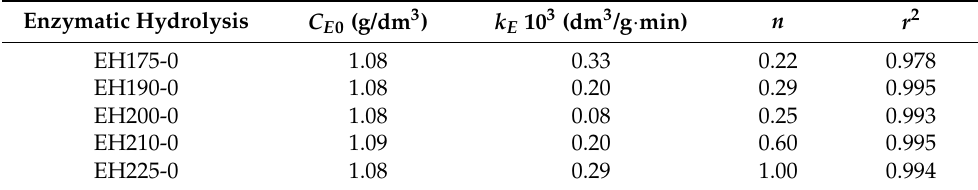
Table 3. Effects of LHW pre-treatment temperature on Chrastil’s model